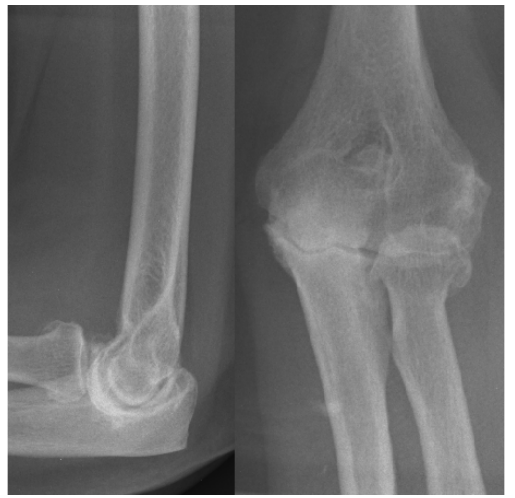
Figure 1 : Plain elbow radiographs show sever arthritic